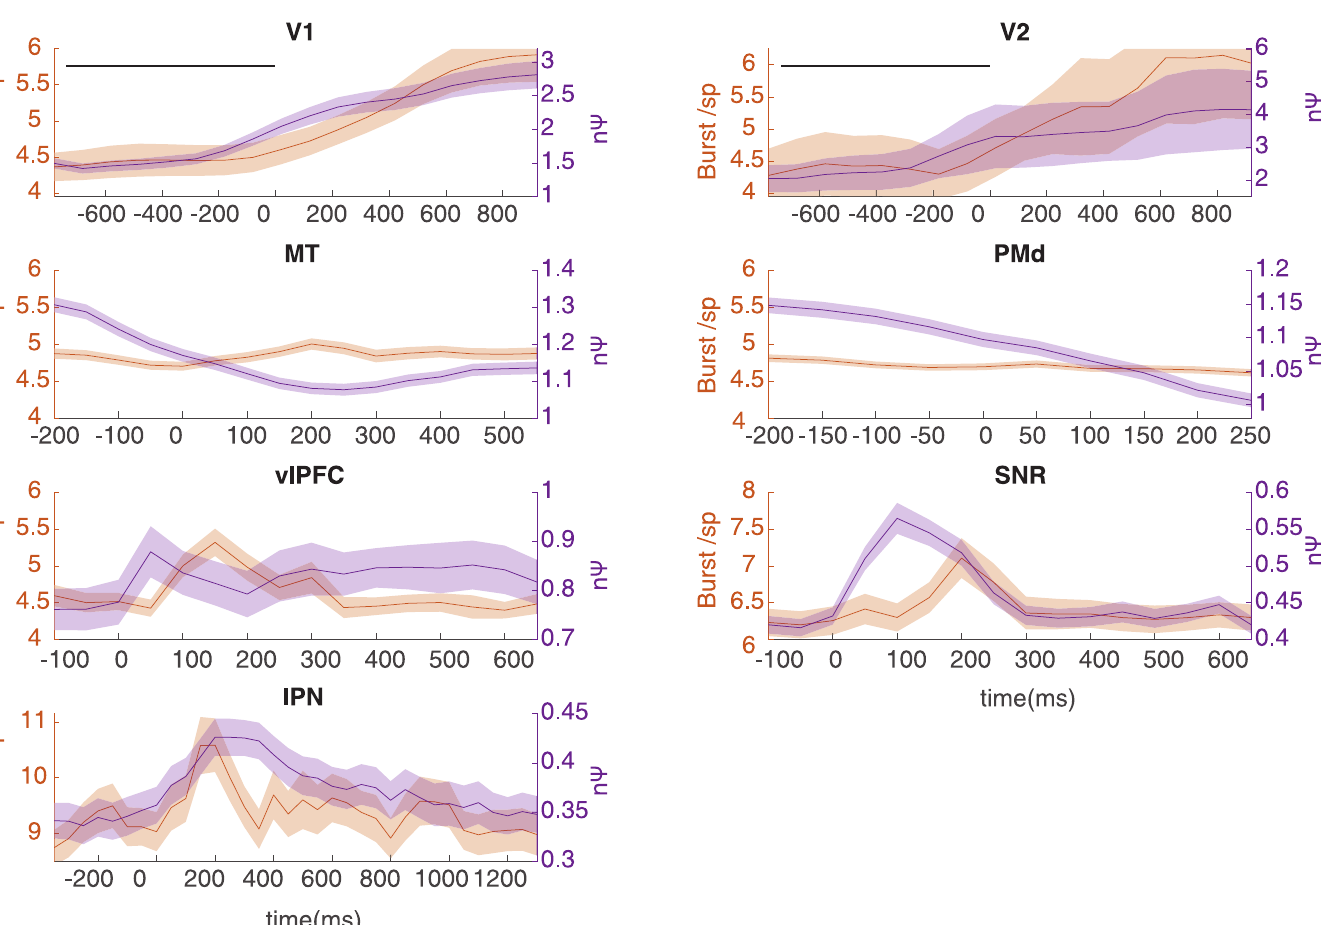
Fig 6. Increase of n C is concurrent with increased bursting across some cortical and subcortical regions. Peristimulus temporal changes in n C is plotted alongside temporal changes in burst count per spike across regions. Burst probability for a spike was small between 5–10% across all regions. Period of stimulus on is before zero in V1 and V2 marked by a line. Only nonresponsive neurons were used in this analysis to avoid confounding effects of firing rate changes (see S1 Text).